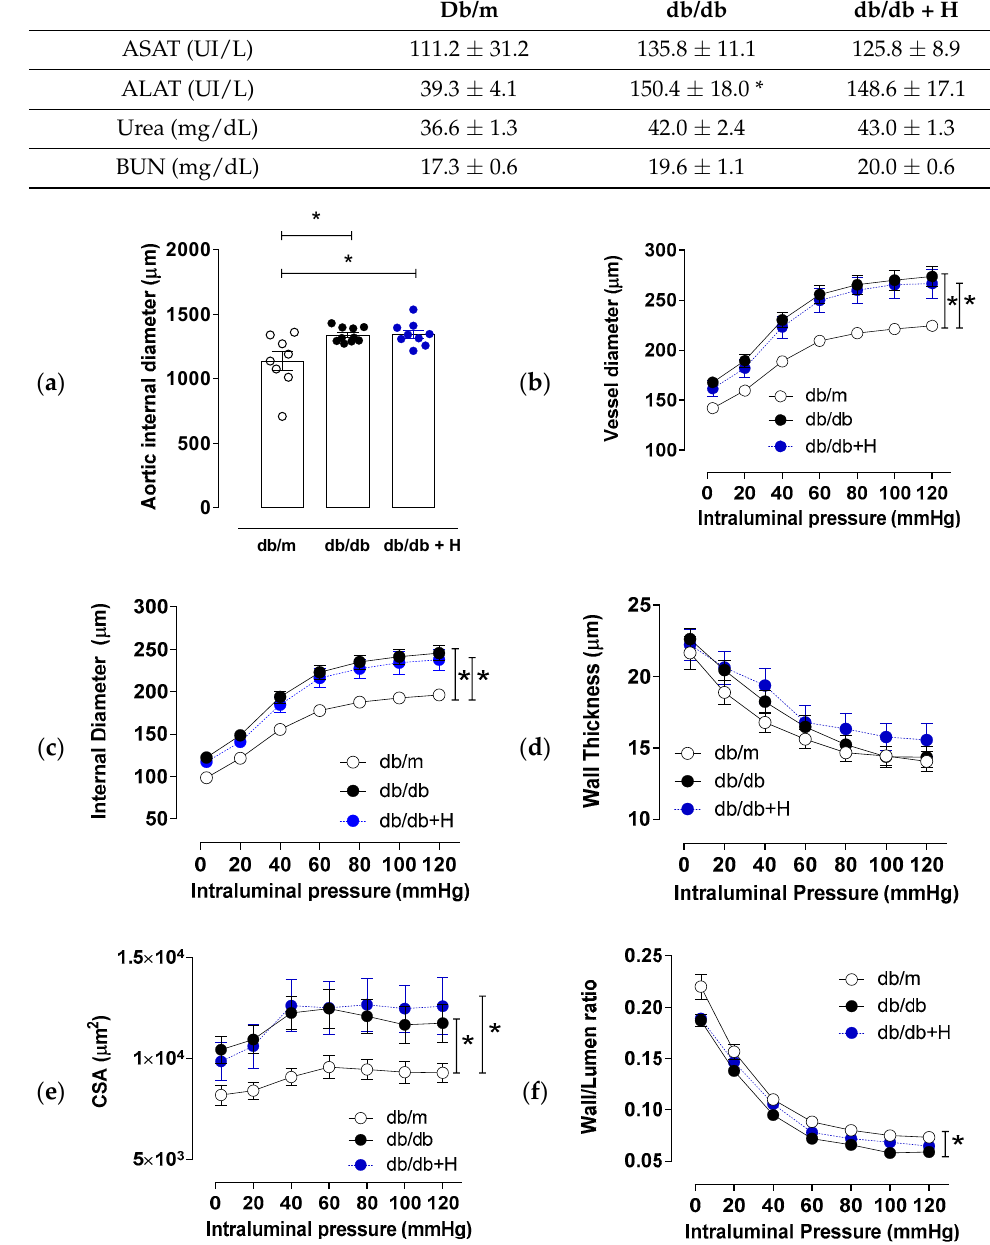
Figure 3. Effect of hidrosmin treatment on structural properties of mesenteric arteries from db/db mouse model. Aorta ( a ) and mesenteric resistance arteries ( b – f ) structural parameters in non-diabetic mice (db/m, n = 8–6), untreated diabetic mice (db/db, n = 10) and hidrosmin-treated diabetic mice (db/db+H, n = 8–9). Graphs represent individual values ( a ) and mean ± SEM of each group ( a – f ). * p < 0.05 vs. db/m by Kruskal–Wallis, followed by Dunn’s post-test ( a ) or two-way ANOVA, followed by Bonferroni’s post-test ( b – f ). Abbreviation: CSA, cross-sectional